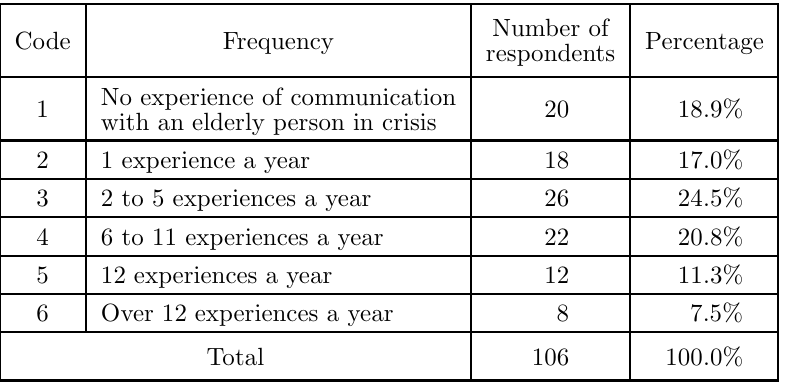
Table 3. Frequency of communication with an elderly person in suicidal